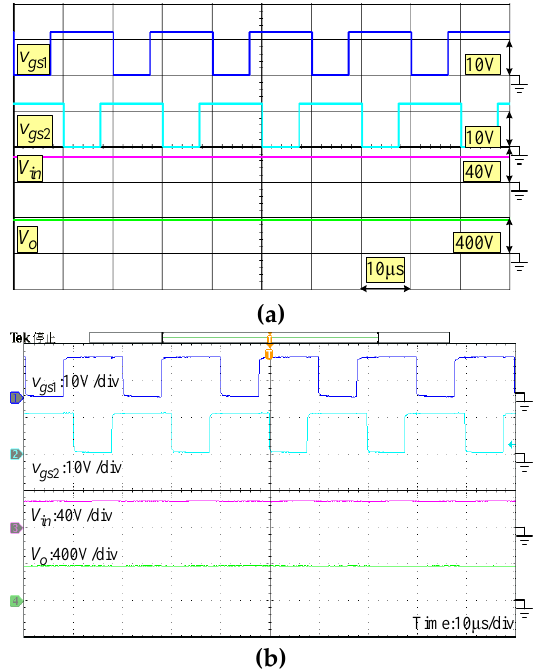
Figure 12. Waveforms of v gs 1 , v gs 2 , V in and V o . ( a ) Simulated results. ( b ) Experimental results.